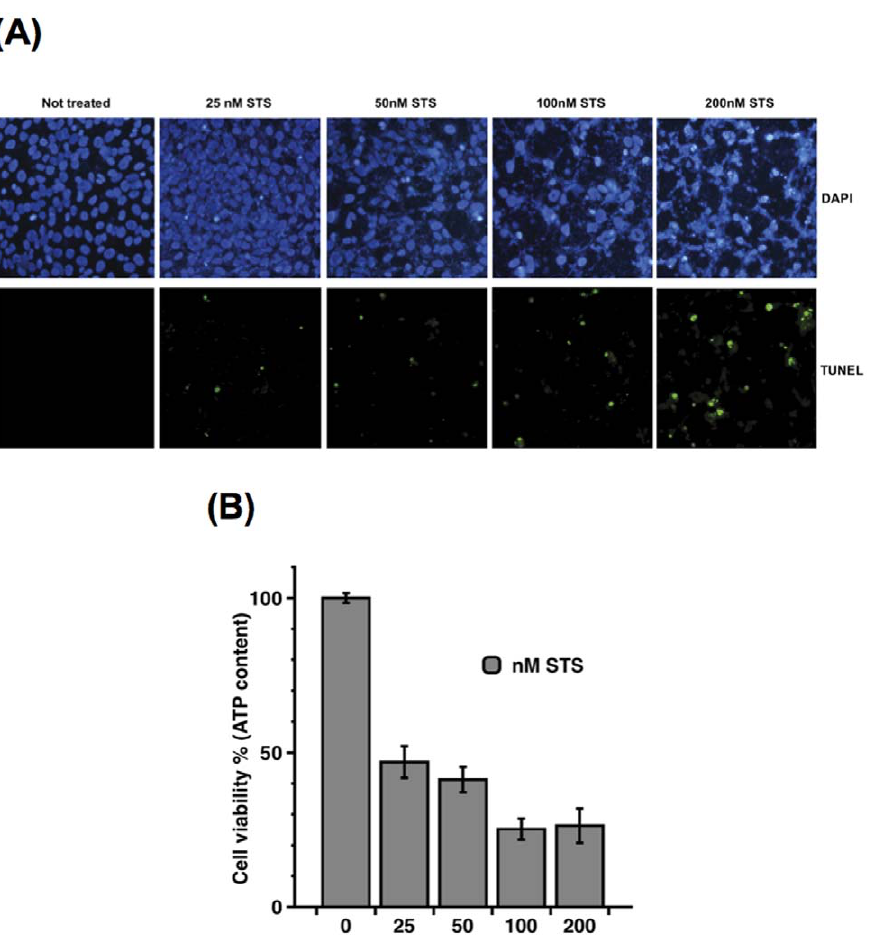
Figure 4. STS-induced apoptosis in 661W cells. Dose-dependent induction of apoptosis in 661W cells exposed to increasing amounts of STS (25 to 200 nM) for 24 h, as depicted by ( A ) increased TUNEL-positive apoptotic cells and ( B ) decreased level of intracellular ATP content. Data are the mean 6 SE of at least four independent experiments, each performed in triplicates.